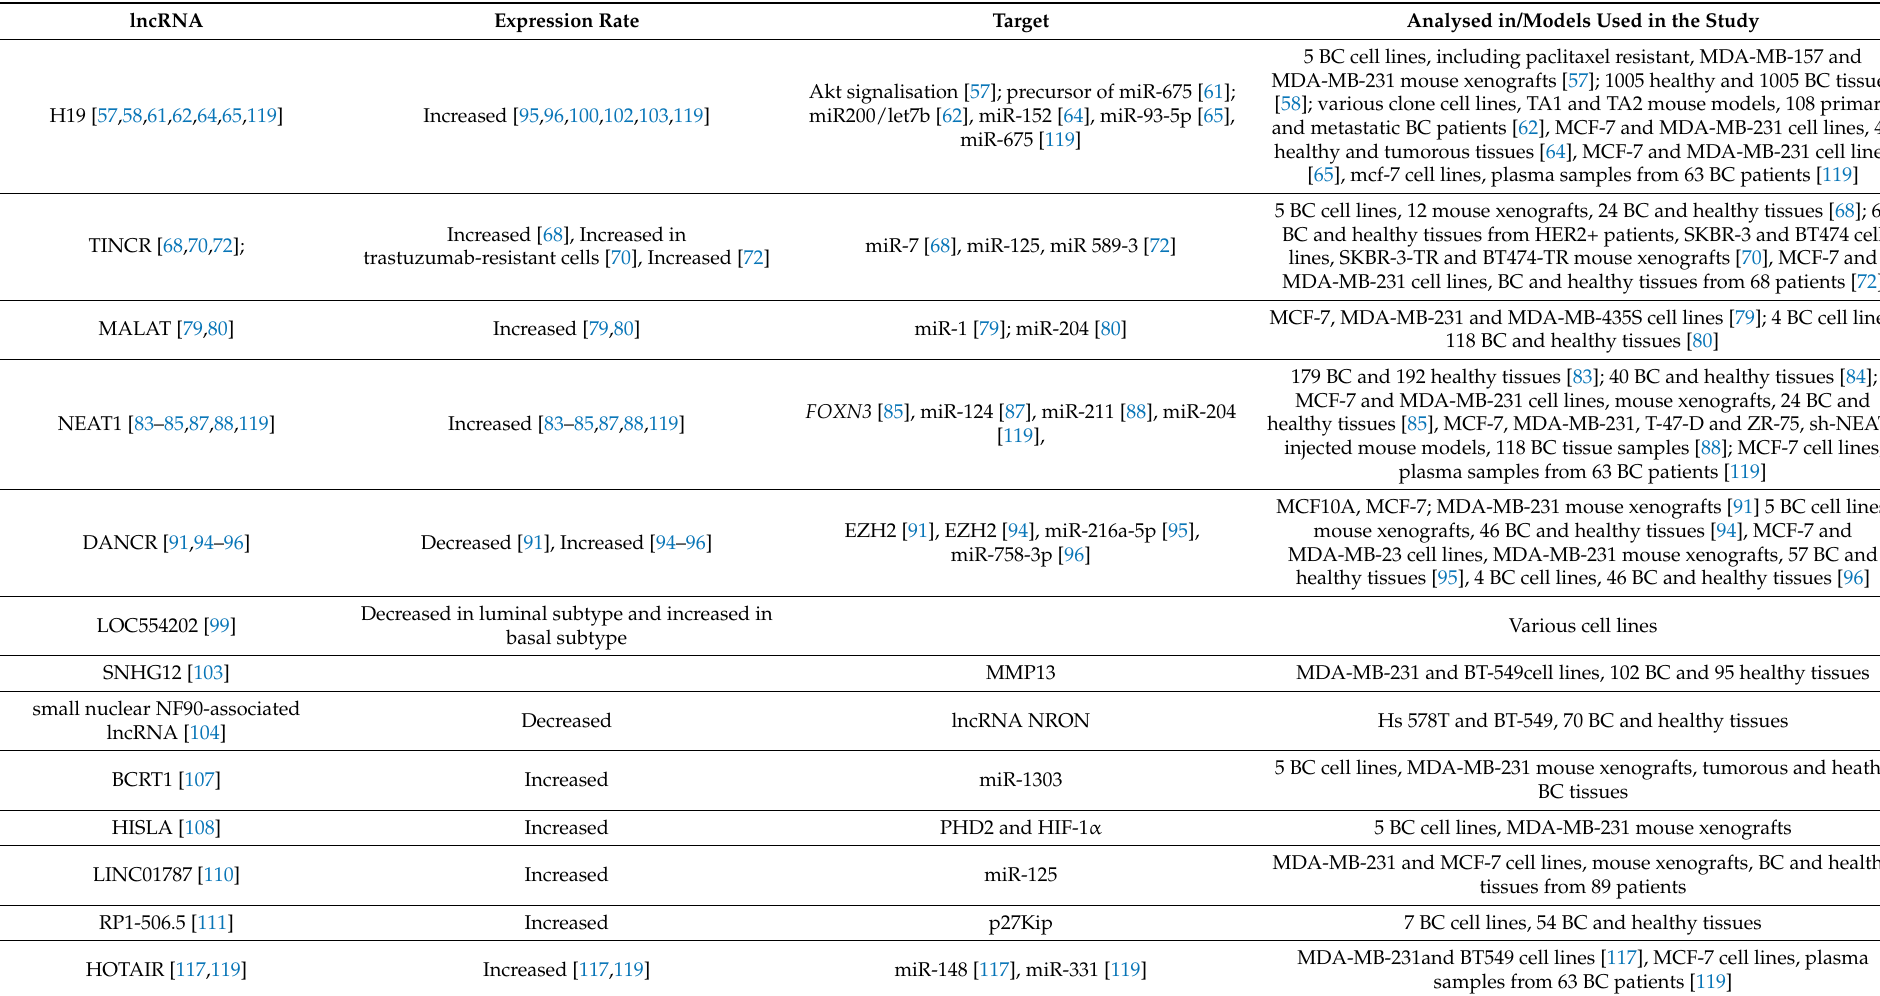
BC—Breast Cancer, lncRNA—long non-coding RNA,